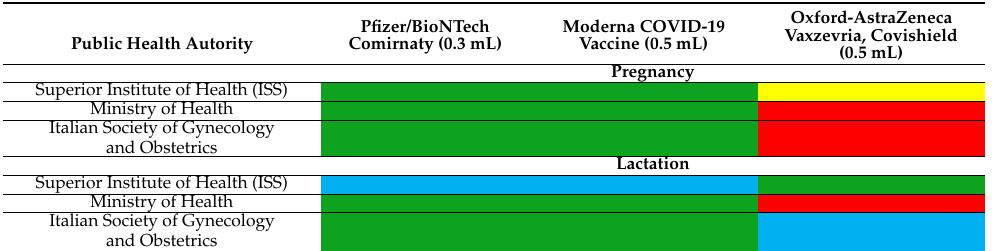
Table 3. Actual policy position of the Public Health Authorities for vaccination during pregnancy and lactation in